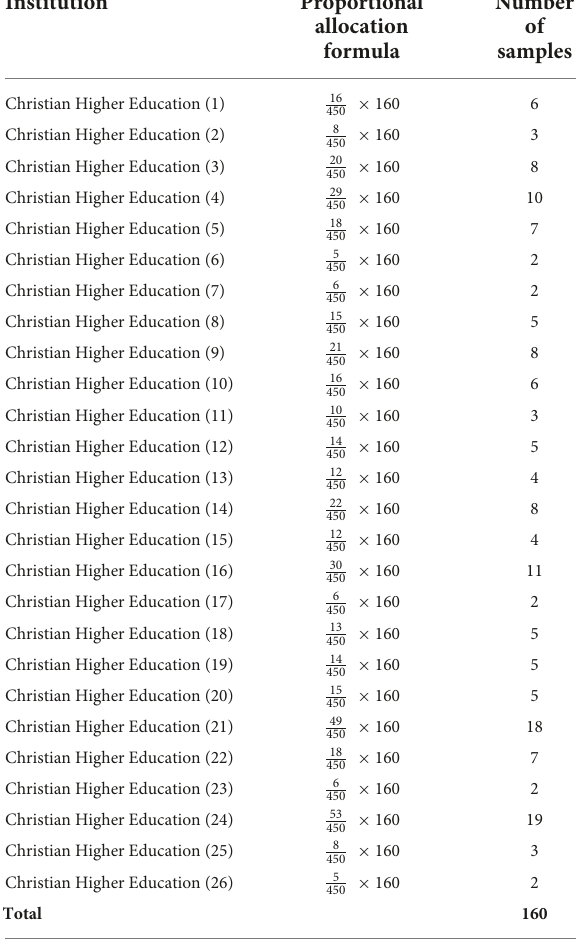
TABLE 1 Sample by area of Christian higher